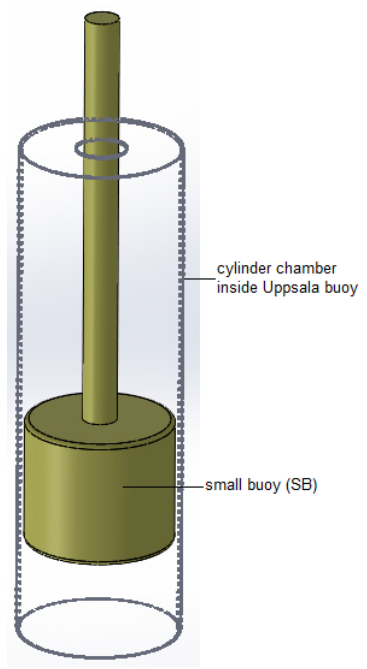
Figure 5. A small buoy is placed in a cylindrical chamber of the Uppsala buoy, see Figure